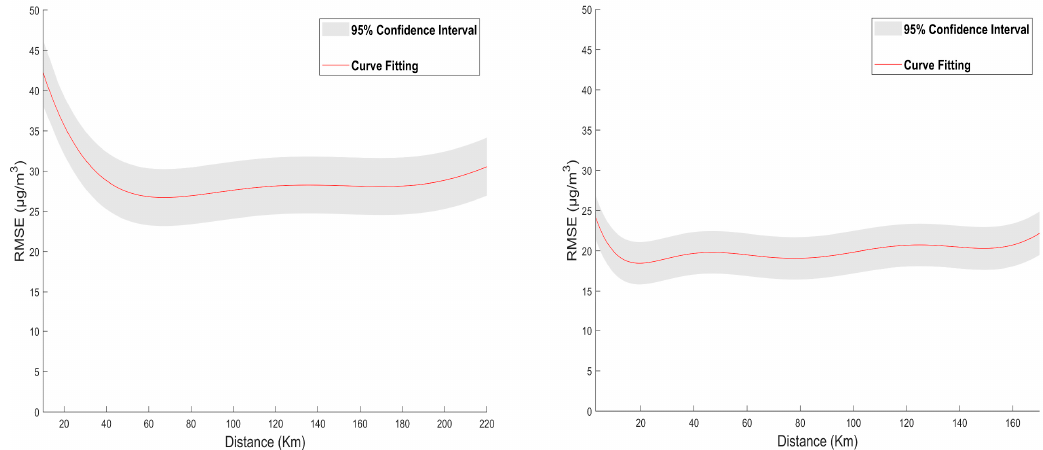
Figure 5. The spatial distribution of sample-based CV RMSE for PM 2.5 ground-level sites. ( a ) is the result of GWR, ( b ) is the result of XGBoost and ( c ) is the result of SL-XGB.